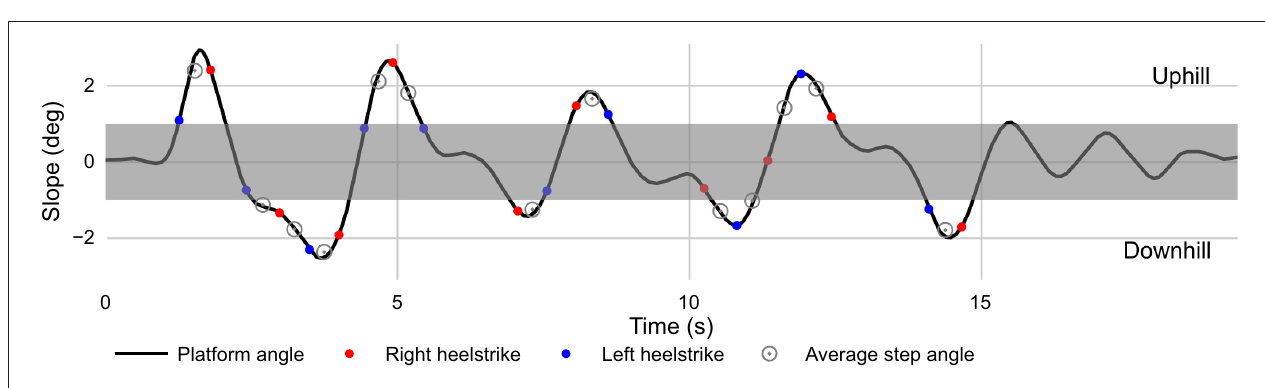
FIGURE 2 | Platform angles throughout the rolling-hills terrain and representative sample of heel-strike gait events and average step angles included in sloped conditions. Average step angles within the shaded region were not counted toward uphill or downhill steps. NB: Figure depicts the AP platform angle throughout the terrain condition, not the elevation of the virtual